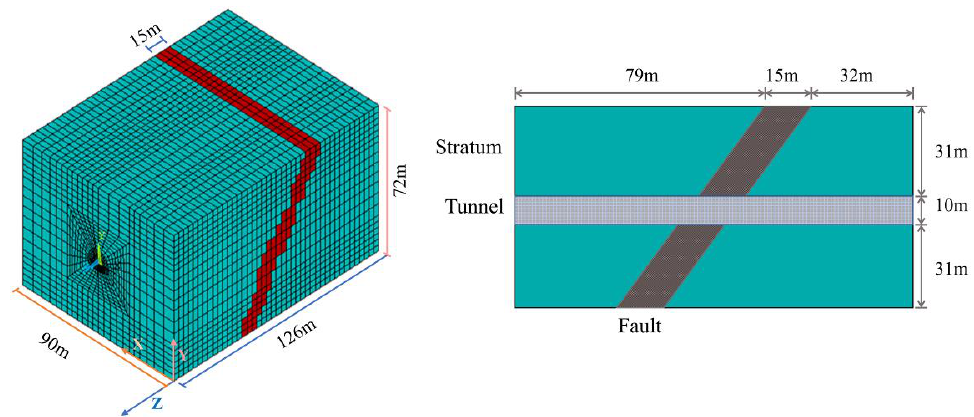
Figure 14. The numerical fault tunnel model of 60° fault dip.